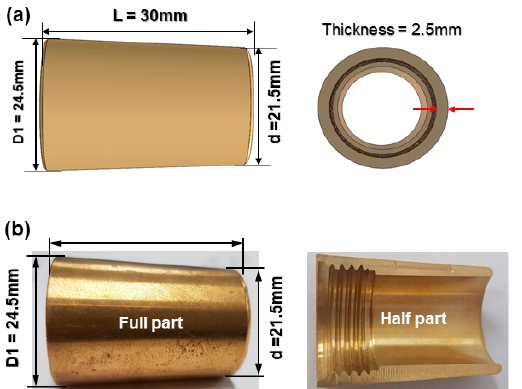
Figure 3. Brass cone pipe ( a ) modeling, ( b ) whole part and half part. Table 1. Prescribed mechanical properties of brass cone pipe (CuZn 3 O).